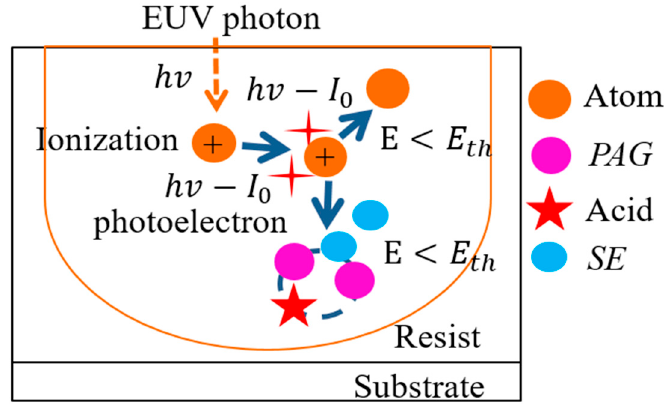
Figure 1. Exposure simulation of Monte Carlo method: molecular processes in a resist-substrate system during EUV exposure. hv , I e , E , E th , PAG , and SE are EUV energy, ionization energy of polymers, energy, threshold energy, photo-acid generator, and secondary electron, respectively.